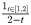
(a-c) Sampling event times with an intensity function 1t∈[1,2]2-t.(a) Generate a random variate from the exponential distribution with rate λ = 1, the sample here is 0.69. (b) We integrate the intensity function until the area is 0.69, here tn = 1.5. (c) This is the intensity function corresponding to the uniform distribution in γ(t)=1t∈[1,2]. (d) Rejection sampling example: Sampling tv from a time-varying intensity function λ(t) = sin2(2t) using an upper-bound of c = 1. Two iterations are shown with rejection probabilities shown in red. After one rejection step, the method accepts in the second iteration and returns tv = 1.3.